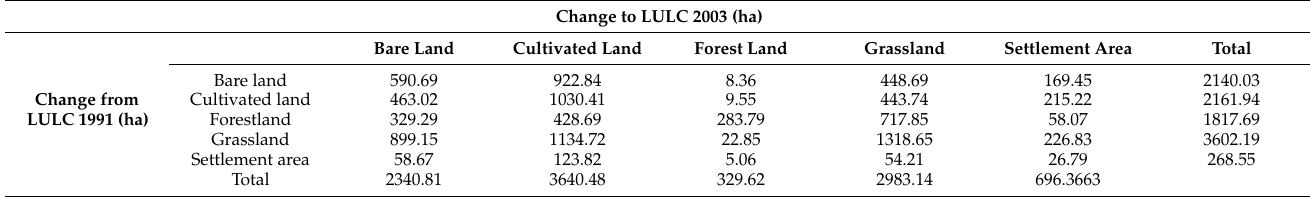
Table 6. LULC change matrices of the Matenchose watershed (1991–2003).